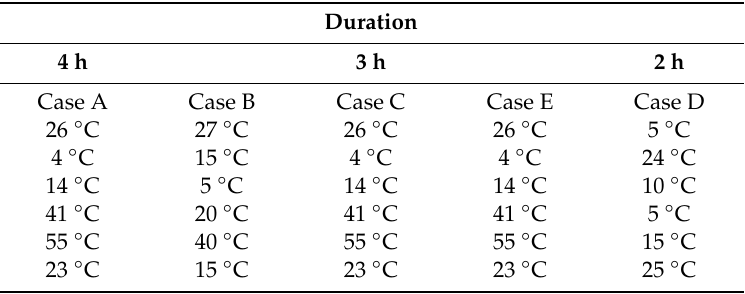
Table 1. Thermal profiles that were applied to the battery.